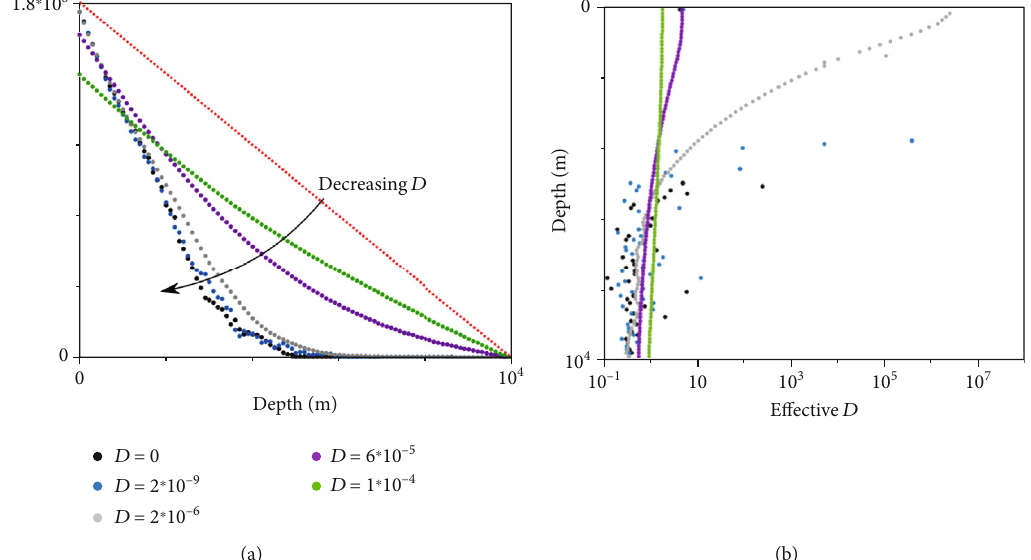
Figure 5: (a) Time-integrated vertical pressure pro fi le. Red line indicates theoretical graph for pure di ff usion. (b) E ff ective di ff usion coe ffi cient with